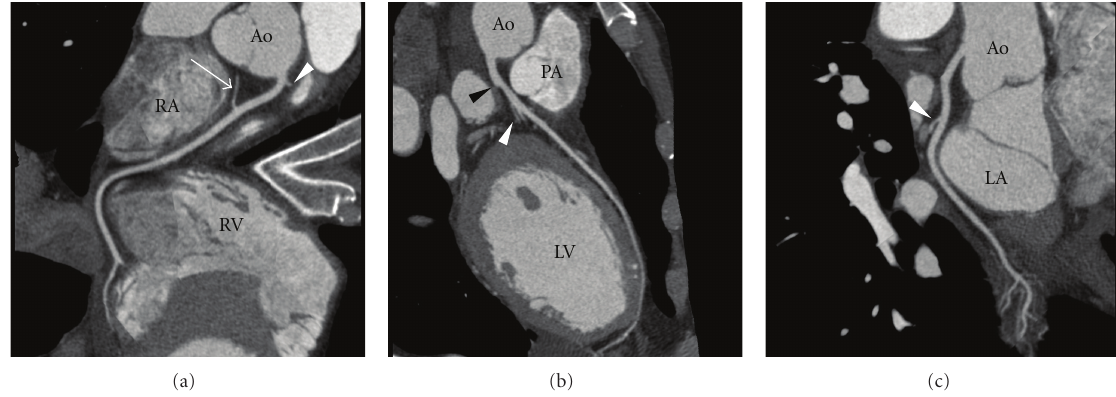
Figure 2: 53-year-old male with metastatic melanoma underwent testing prior to Interleukin-2 (IL-2) therapy. Resting electrocardiogram and echocardiogram are normal. Dobutamine stress echocardiogram shows inferior wall inducible ischemia. IL-2 is held while coronary CT angiography is performed. Based on CT findings, IL-2 is started and given uneventfully. (a) Curved reformat view of the right coronary artery shows no atherosclerotic plaque. The conus branch (arrowhead) and sinoatrial nodal branch (arrow) are identified. (b) Curved reformat view of the left anterior descending artery shows no atherosclerotic plaque. The circumflex artery origin (black arrowhead) and first diagonal artery (white arrowhead) are identified. (c) Curved reformat view of the circumflex coronary artery shows no atherosclerotic plaque. The first obtuse marginal branch (arrowhead) is identified. LA = left atrium. LV = left ventricle. RA = right atrium. RV = right ventricle. Ao = Aortic root. PA = pulmonary artery root.